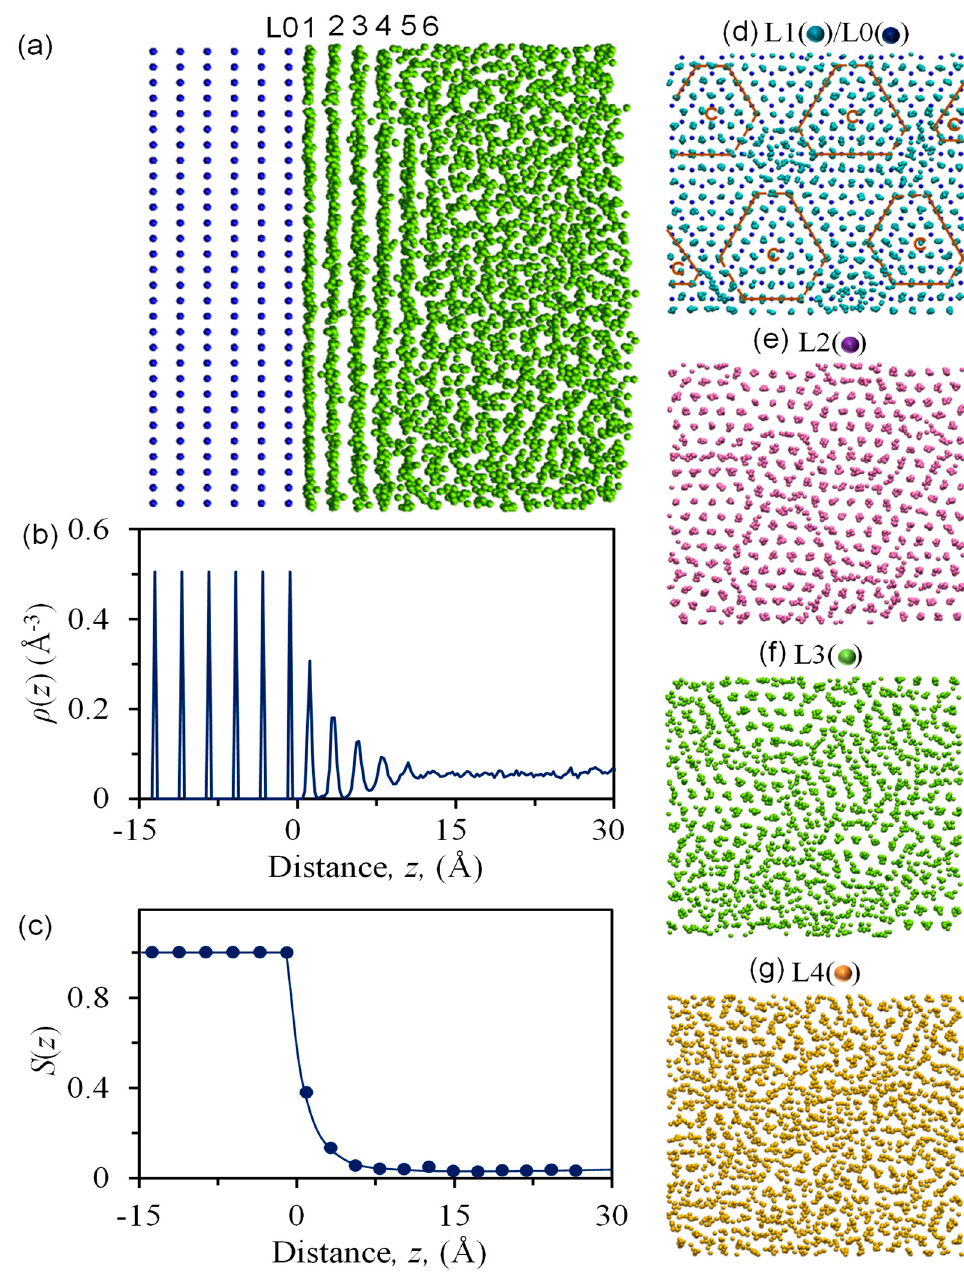
Figure 3. Precursor of heterogeneous nucleation. ( a ) A snapshot, and ( b ) atomic density profile, ρ ( z ), and ( c ) in-plane order parameter, S ( z ), as a function of the distance, z , from the interface at the onset of nucleation ( t = 0 ps) for the simulation system with f = − 8% at T n = 760 K. There are six notable atomic layers in the liquid, but only the first two layers contain some degree of in-plane ordering. ( d – g ) Time-averaged atomic positions of the L1, L2, L3, and L4 layers at the interface are indicative of 2D ordered structure. For comparison, L0 is also shown in ( d ). “C” marks the stacking fault that is surrounded by partial edge dislocations (the solid lines).